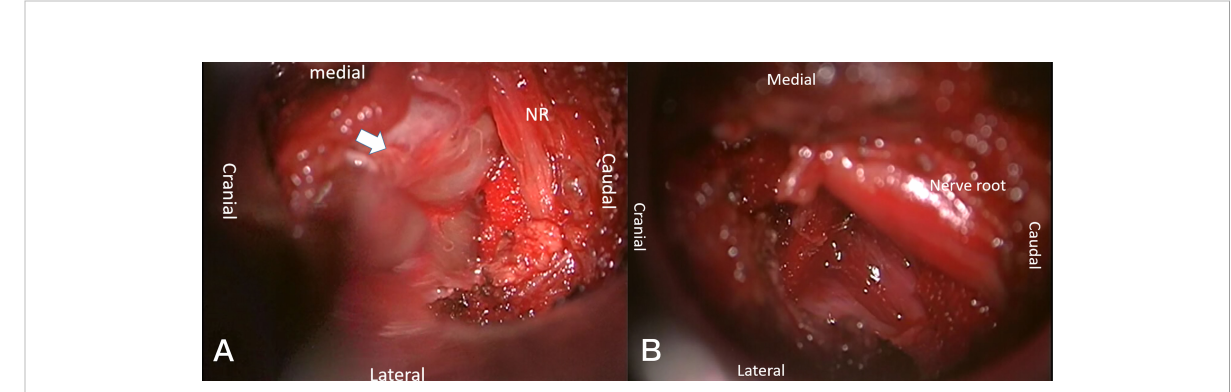
FIGURE 1 Tumor resection of Eden 4 type by PAMT. After inserting the micro-tubule, the relevant anatomy was exposed (A) : paravertebral tumor (white arrow) and nerve root (NR). The nerves remained intact after tumor resection (B)